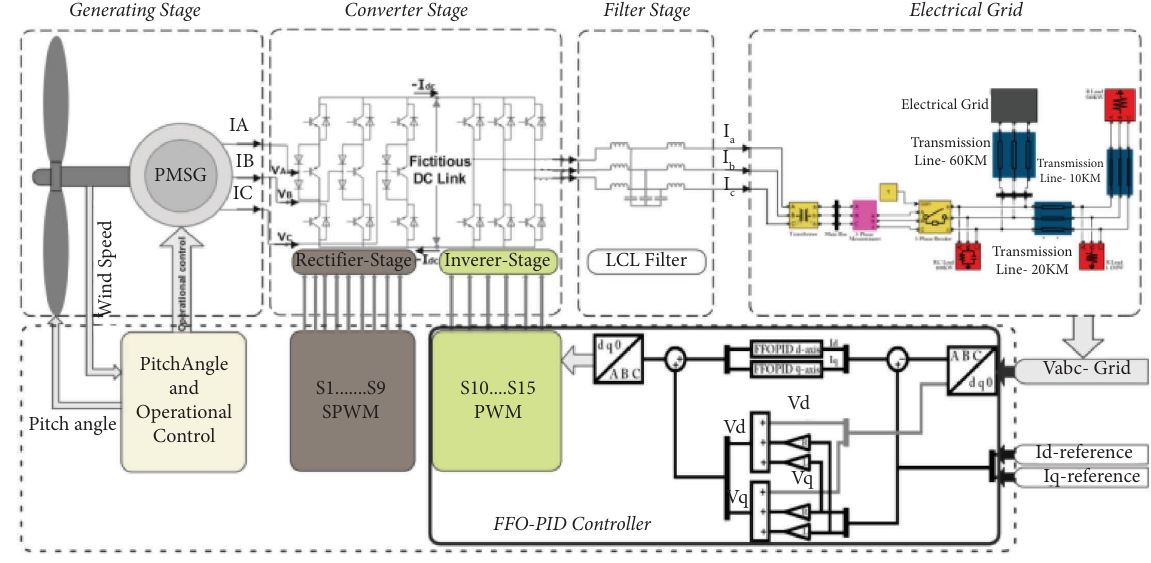
Figure 6: Te general model of the SMC based